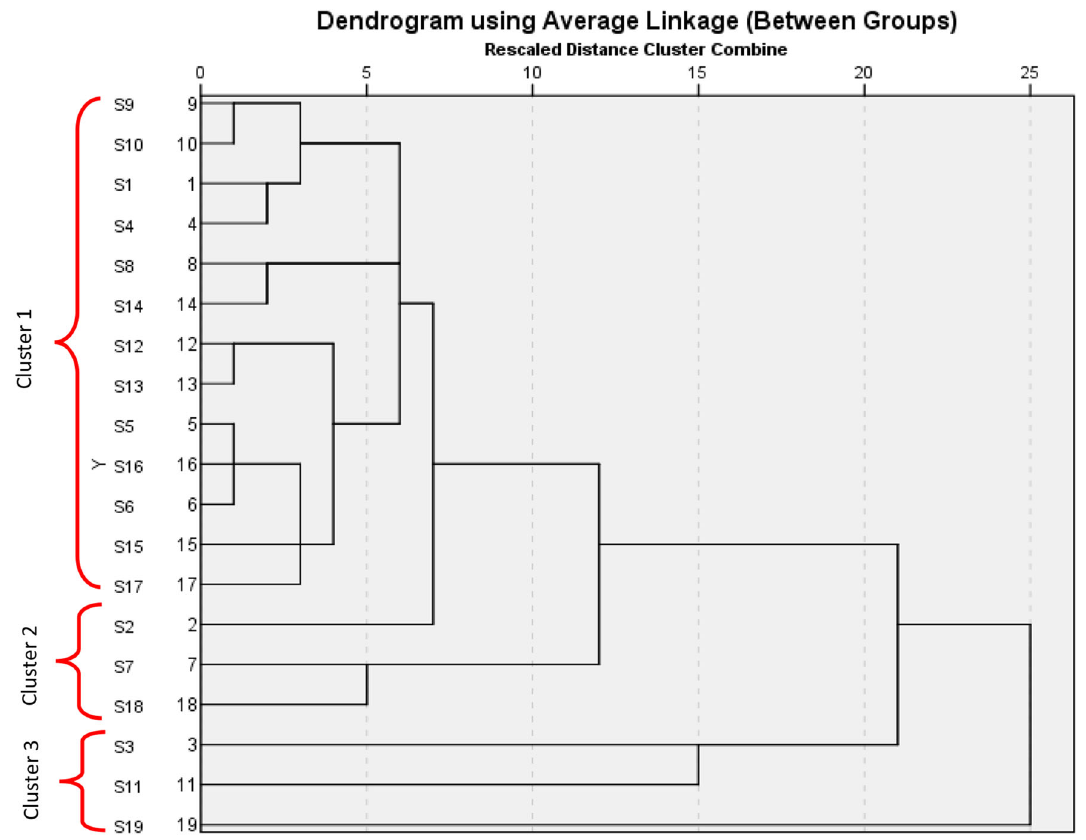
Fig. 12 Dendrogram showing the hierarchical clusters of sampling